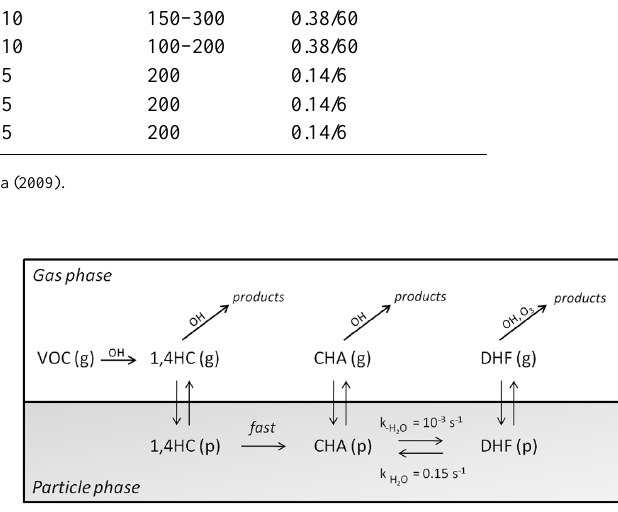
Figure 3. Representation of DHF formation in the GECKO-A pro-